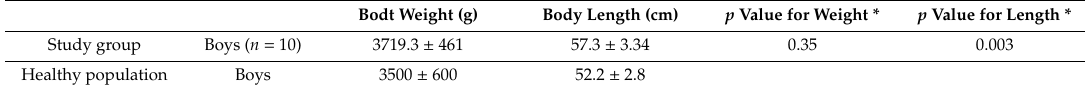
Table 2. Comparison of birth length and weight at birth among boys with MPS IVA and healthy controls. Bodt Weight (g) Body Length (cm) p Value for Weight * p Value for Length